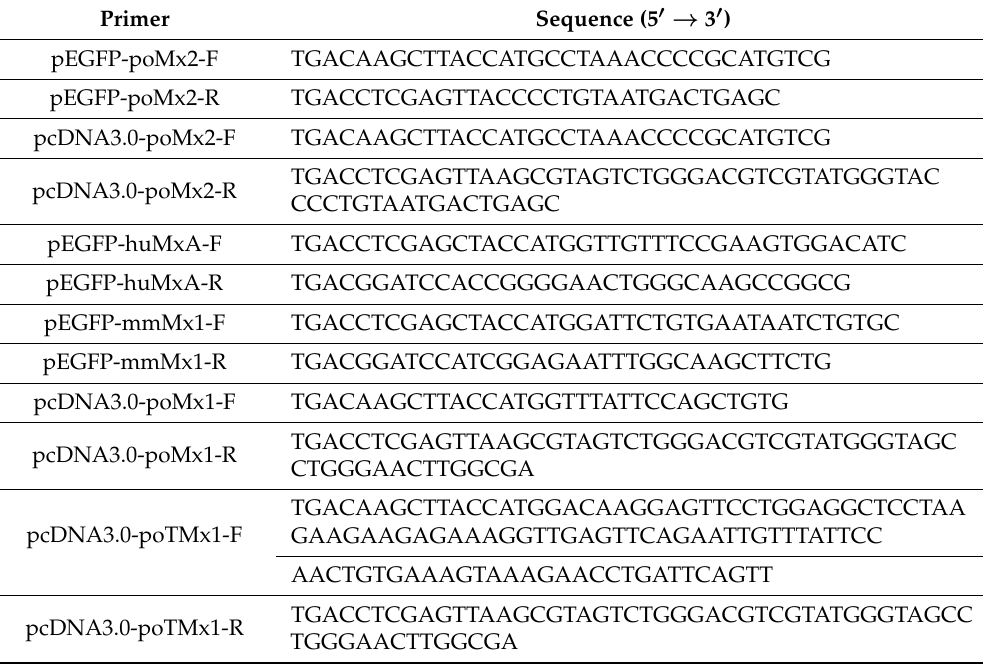
Table 1. Primers used in this